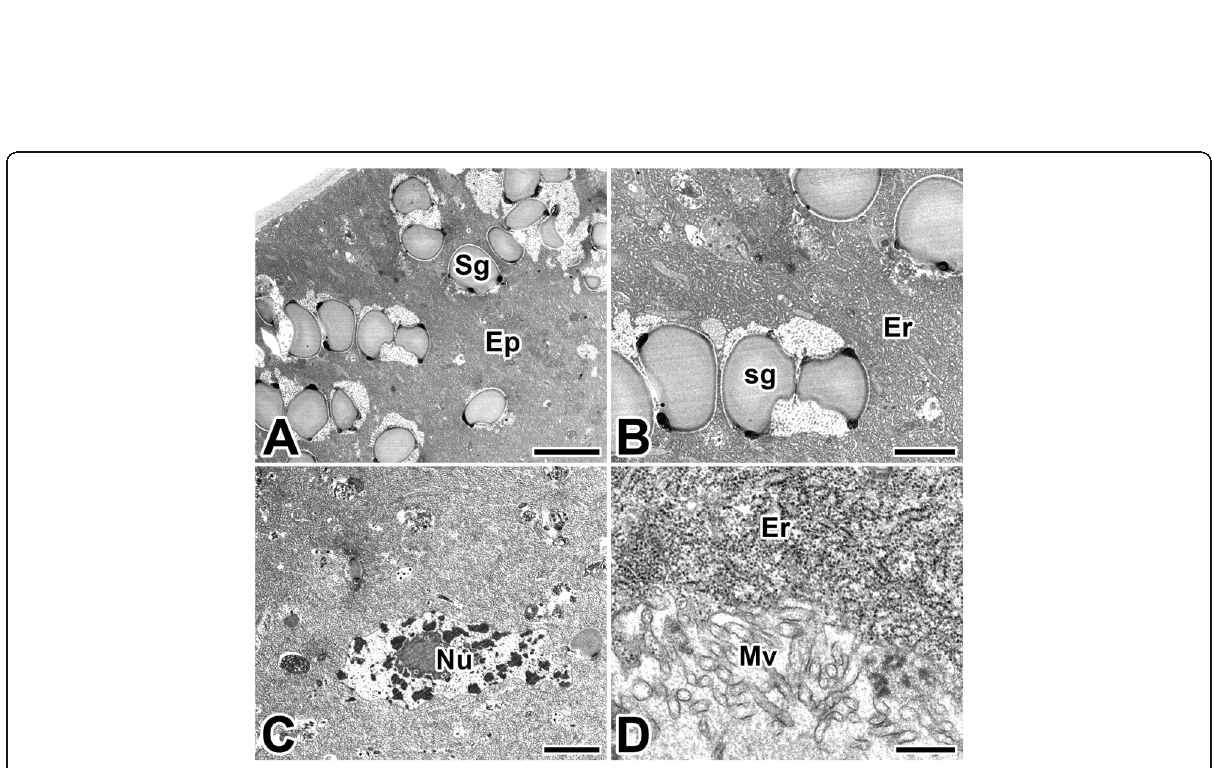
Fig. 7 Transmission electron micrographs of the posterior region of the silk gland in the caddisworm H. nigrovittatus. a , b Secretory silk products are visible as large secretory globules (Sg) in the epithelium (Ep). Er: rough endoplasmic reticulum. c , d Secretory products are transported across apical microvilli (Mv) by exocytosis, and they are released to the lumen as a major silk substance. Nu: nucleus. Scale bars indicate 5 μ m ( a ), 2 μ m ( b ), 5 μ m ( c ), and 0.5 μ m ( d ),